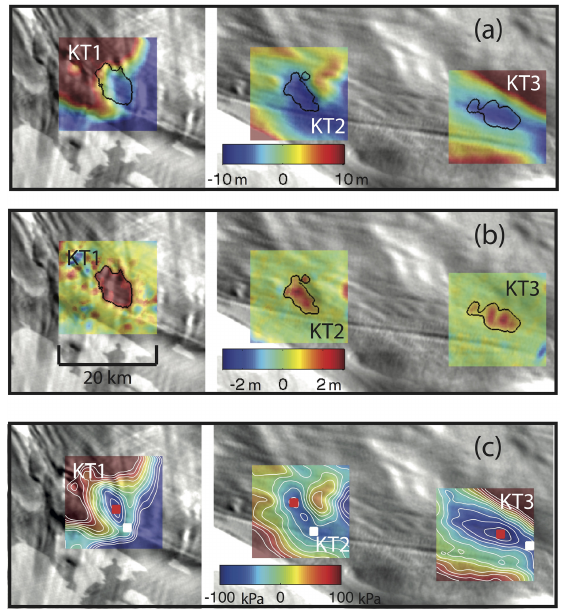
Figure 3. Ice surface elevations and subglacial hydraulic potentials around the three subglacial lakes KT1, KT2, and KT3, overlaid on the MOA image. (a) Reference DEMs (colored shading) derived by the kriging method using the CryoSat-2 elevation measurements. (b) Elevation anomalies deviated from the reference DEMs in the time windows as described in the text. (c) Relative hydraulic poten- tial anomalies calculated using the reference DEMs and ice thick- ness from Bedmap2. The contour lines are plotted at 20kPa inter- vals. Red squares indicate the centers of the hydropotential lows, and the white squares indicate the predicted outlets. Note that the mean values of elevation and hydraulic potential in each rectangu- lar area are subtracted in order to reveal the